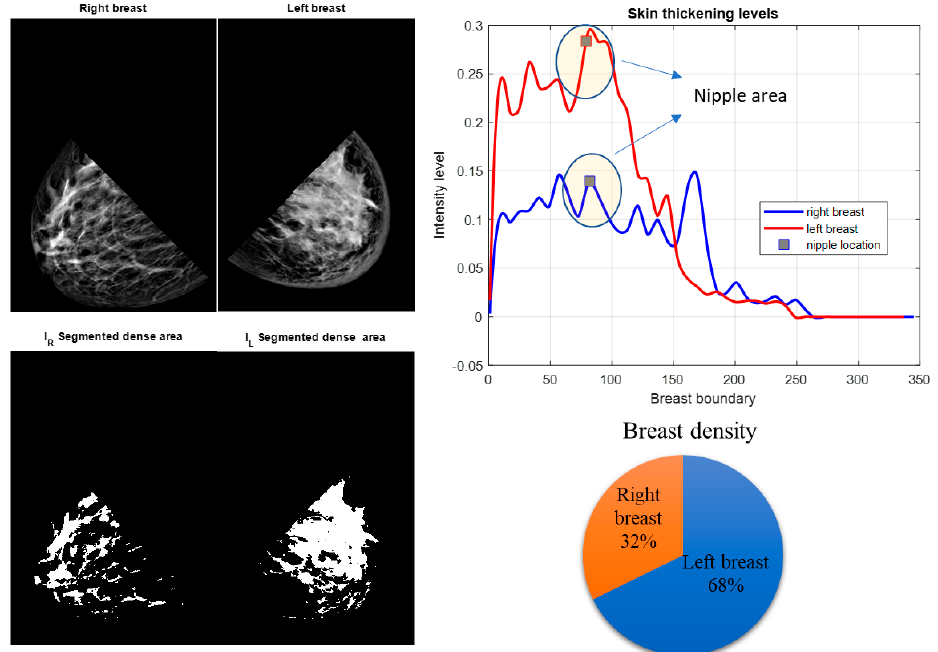
Figure 3. IBC patient. MLO view. The lower quadrants of the right and left breast are segmented. Breast density in both breasts is measured. The right and left breast skin thickening and density are calculated as average intensity values and compared. The left breast is clinically diagnosed with IBC while the right breast is normal. Figures show higher skin thickening and breast density for the left breast.